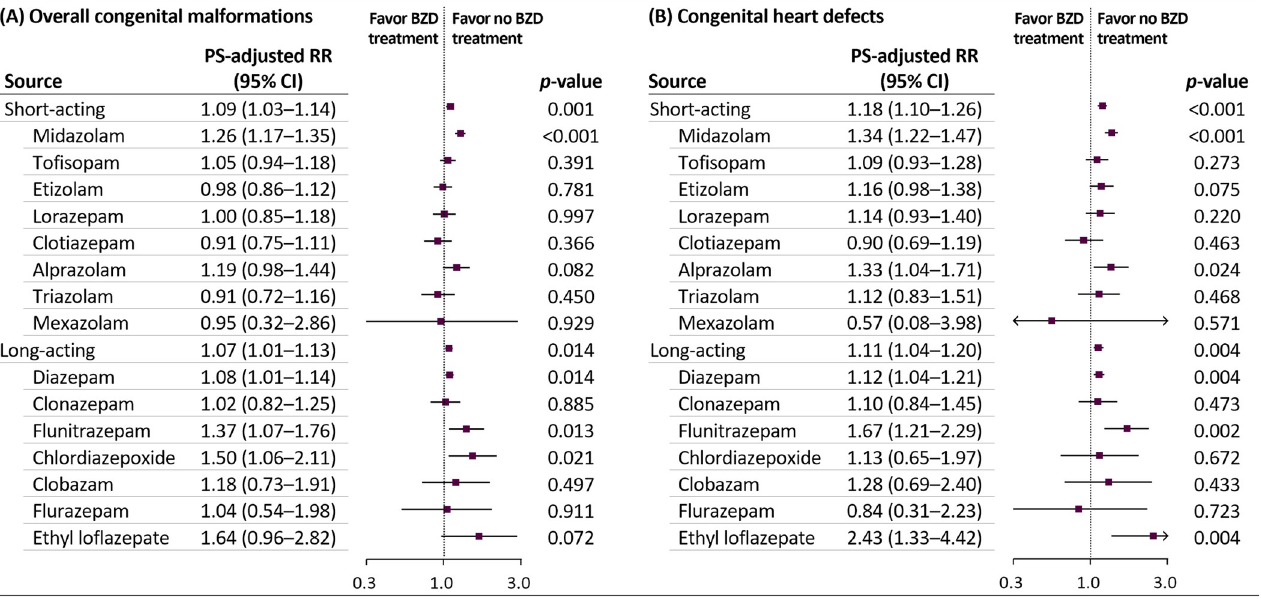
Fig 3. Risks of congenital malformations in infants according to individual benzodiazepine exposure during the first trimester. BZD, benzodiazepine; CI, confidence interval; RR, relative risk; PS, propensity score. Clorazepate was not analyzed owing to the small sample size ( n = 14).